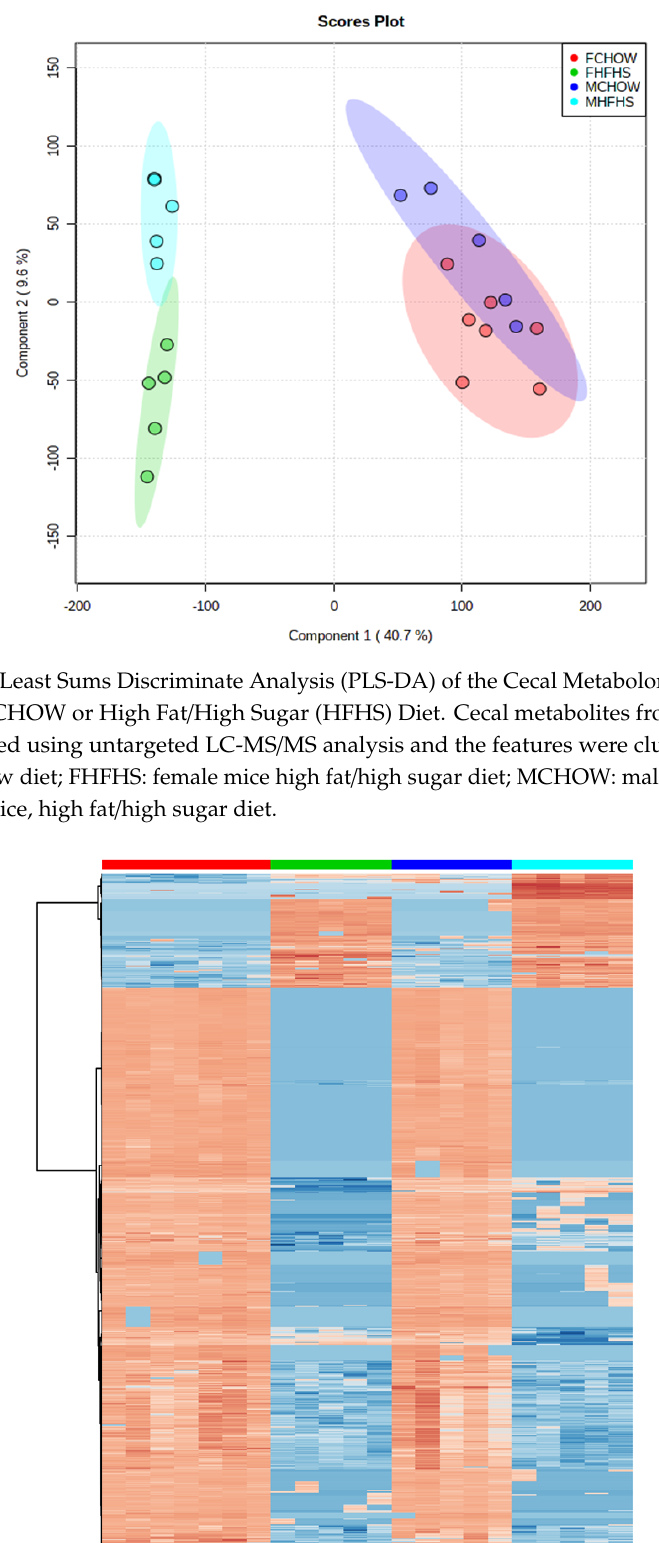
Figure 2. Heat Map of Top 1000 Differentially Expressed Features in Female and Male Mice on a CHOW or HFHS Diet. A total of 10,961 features were detected in cecal contents across all mice ( n = 22). Of these, 2837 and 1669 features were significantly different between female and male mice, respectively, on either diet. A total of 147 features were significantly ( p < 0.01) different between female and male mice on the HFHS diet. Columns represent specific mice from each group. Rows are unique features detected via LC-MS/MS. Darker red indicates relatively abundant features and dark blue indicates relatively depleted features. FCFD: female mice, chow diet; FHFHS: female mice high fat/high sugar diet; MCFD: male mice, chow diet; MHFHS: male mice, high fat/high sugar diet.